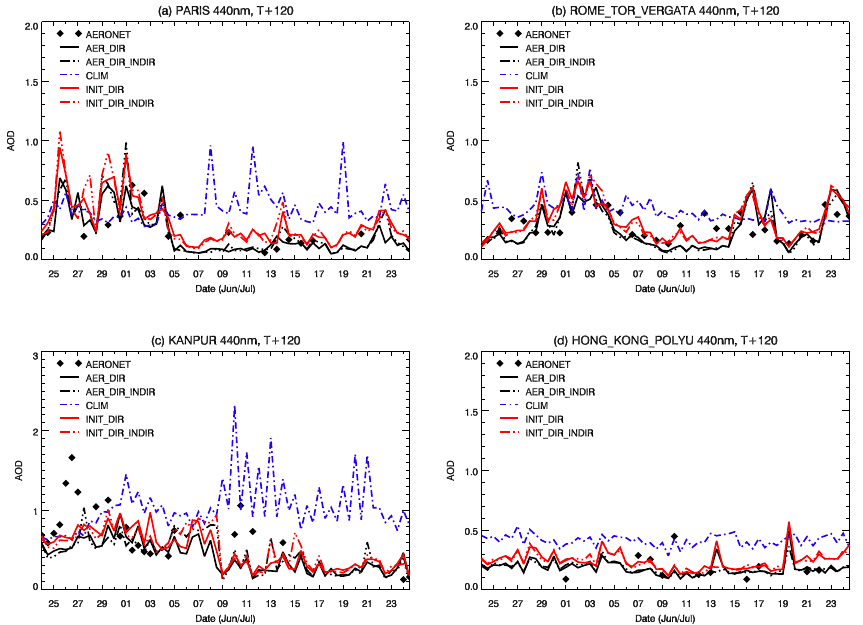
Fig. 4. Timeseries of T +120 forecast AOD (440 nm ) in locations where anthropognenic aerosol is predominant (a) Paris, (b) Rome, (c) Kanpur and (d) Hong Kong.